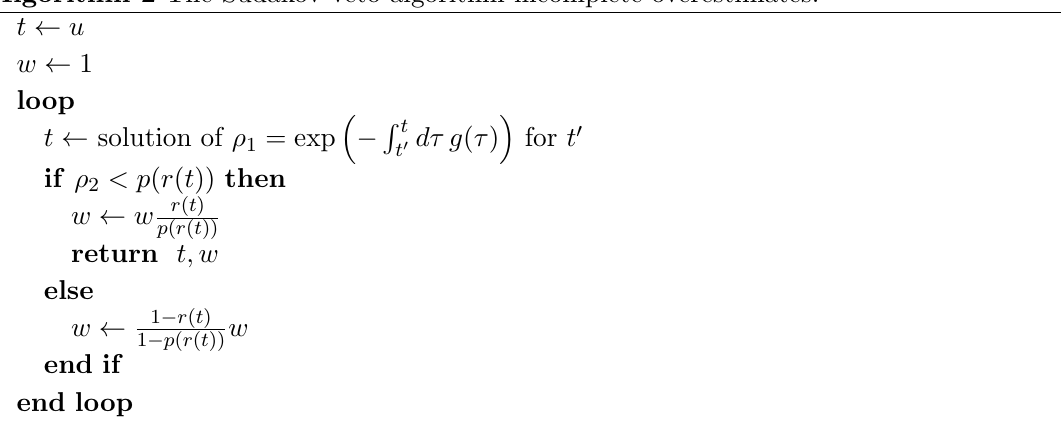
Algorithm 2 The Sudakov veto algorithm incomplete